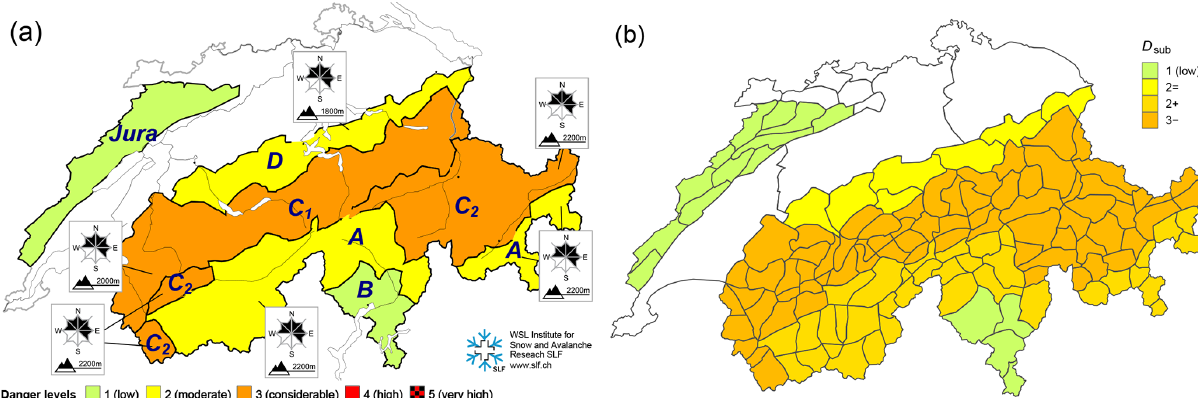
Figure 2. Maps of Switzerland showing (a) the avalanche forecast published on 10 March 2018 and (b) the (unpublished) sub-levels for this forecast. In addition, the warning regions , the smallest spatial units used in the Swiss forecast, are shown as polygons with grey outlines in (b) . These are aggregated to danger regions in the published forecast (i.e., region A in a